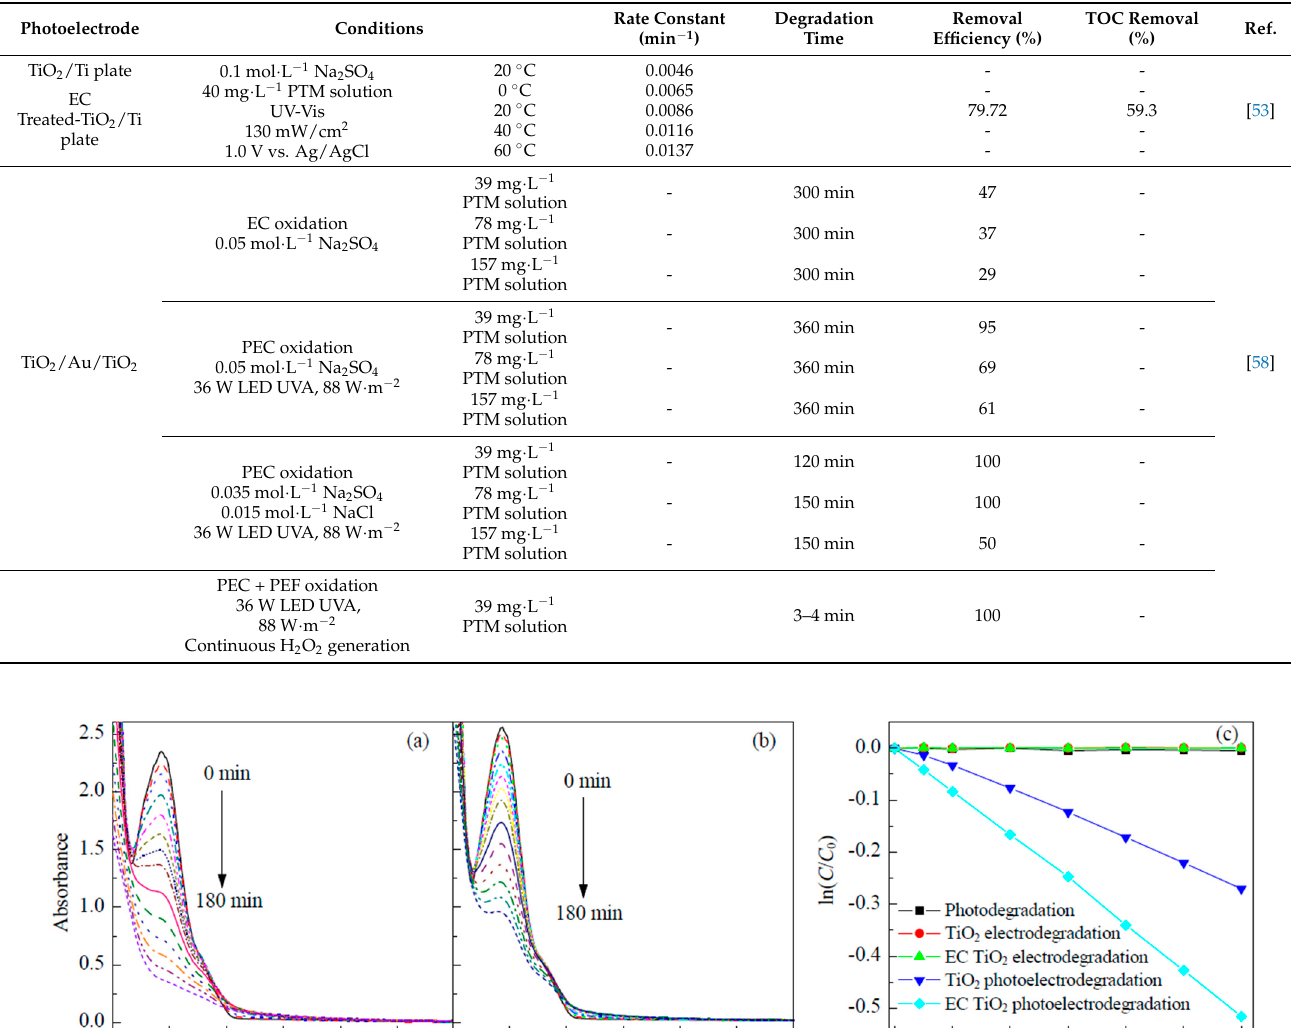
Table 1. PEC acetaminophen degradation using TiO 2 -based photoelectrodes.